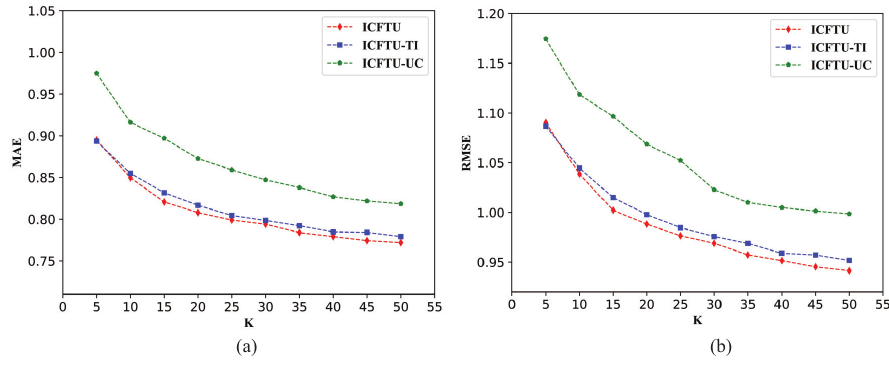
Figure 9. The results of the ablation experiment: ( a ) of MAE; ( b ) of RMSE.